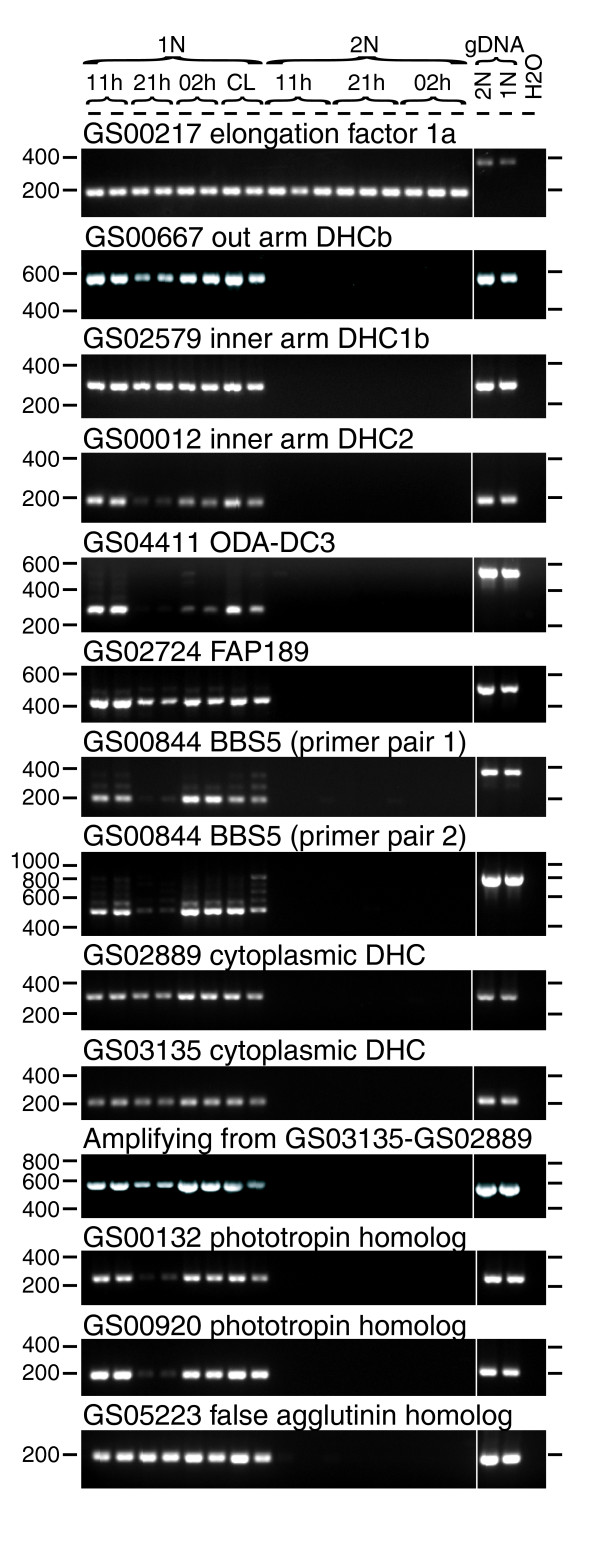
RT-PCR confirmation of expression of selected flagellar-related genes only in 1N cells. All reactions were run with the same RT+ cDNA samples. The RT-PCR shown at the top used the elongation factor 1α (GS000217) as a positive (loading) control showing successful cDNA amplification occurred in all samples. RT- control reactions prepared from the same RNA were run for nine of the PCRs shown here and no contaminating genomic DNA (gDNA) was ever found (see examples with RT- reactions included in Figure S6 in Additional data file 1). For clarity, RT- control reactions run simultaneously have been cut out here. Positions of molecular weight markers on each side of the gel are shown. The sample identifiers are listed for each lane at the top of the gel. 11 h, harvested at 11 h (late morning); 21 h, harvested at 21 h (early evening, time of S-phase); 02 h, harvested at 02 h (after cell division); CL, cultures (1N only) exposed to continuous light.